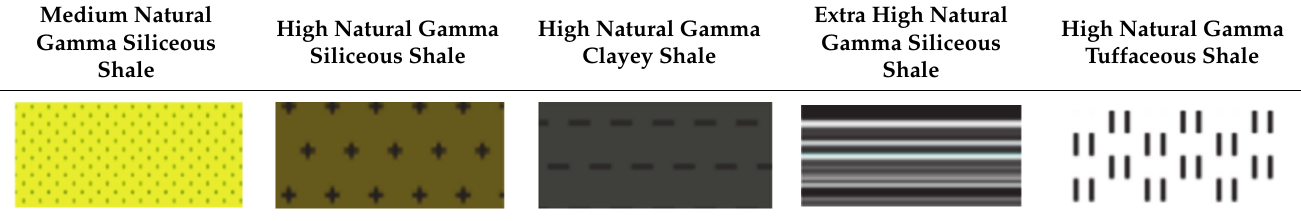
Figure 9. Results of lithology identi fi cation of well J3 in sample data well. Table 2. Icon representation of different lithologies.